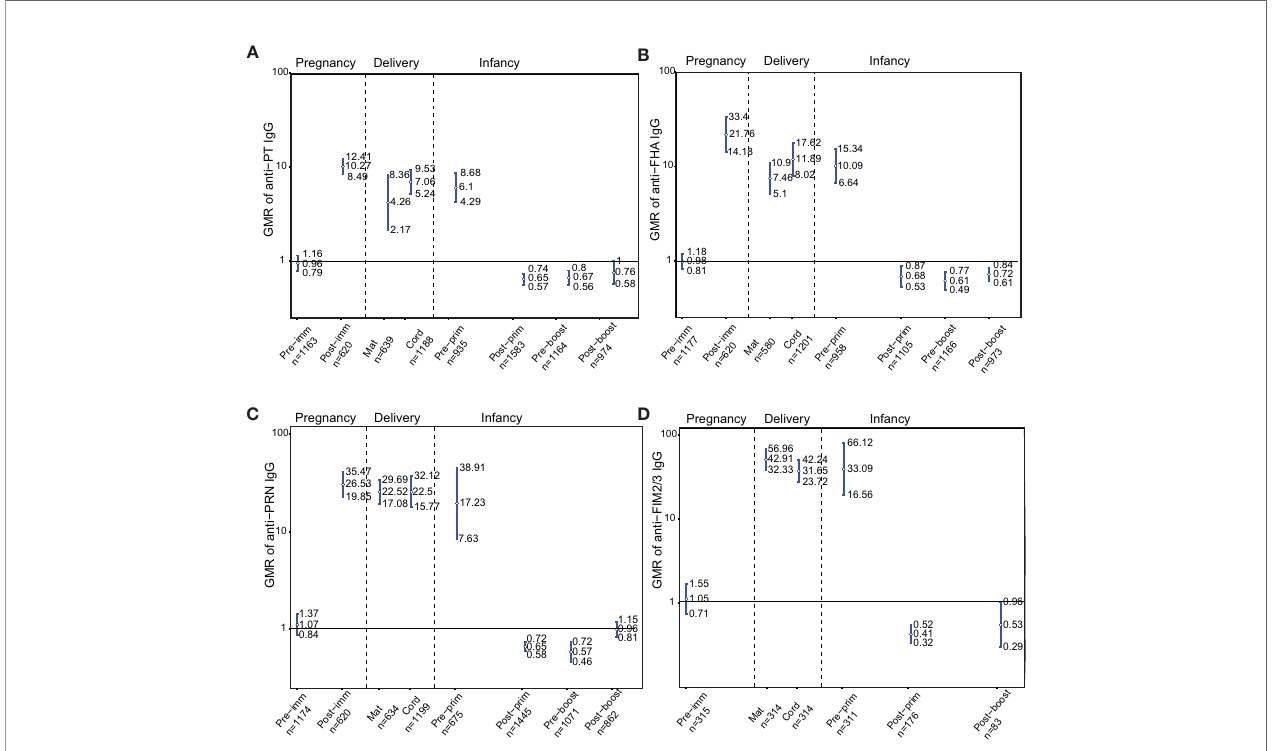
FIGURE 2 | Antibody responses to pertussis antigens. Geometric mean ratio (GMR) of (A) anti-pertussis toxin (PT). (B) anti- fi lamentous haemagglutinin (FHA), (C) anti-pertactin (PRN), and (D) anti- fi mbria 2/3 (FIM2/3) IgG levels in women immunized with tetanus-diphtheria-acellular-pertussis (Tdap) versus women who did not receive Tdap in pregnancy pre-immunization, post-immunization and at delivery; in infants born to women immunized with Tdap versus infants of women not immunized with Tdap in pregnancy pre-primary, post-primary, pre-booster and post-booster immunization with diphtheria-tetanus-acellular-pertussis. For FIM2/3, GMR was not computed post-immunization in pregnancy and pre-booster immunization in infancy, as data were available for one study on these time points precluding meta-analysis. Vertical blue lines indicate the GMR with the 95% con fi dence interval. Horizontal black line indicates a GMR of 1. The numbers available for meta-analysis are indicated (n). GMR results displayed are derived from mixed-effects models. Pre-imm, pre-immunization; Post-imm, post-immunization; Mat, maternal; Pre-prim, pre-primary; Post-prim, post-primary; Pre-boost, pre-booster; Post-boost,